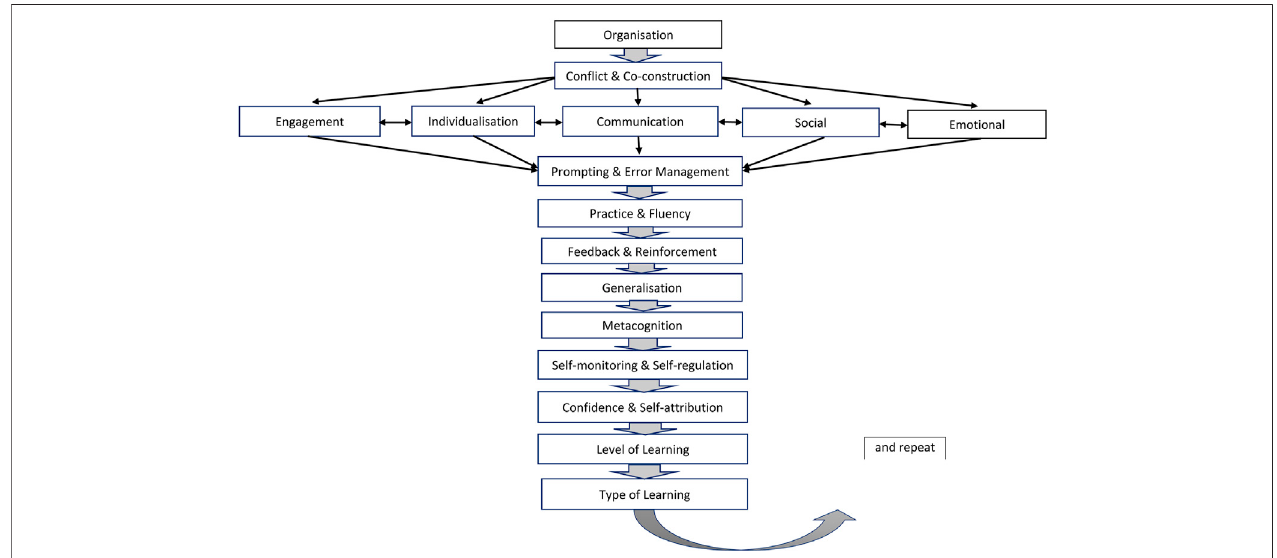
FIGURE 1 | Theoretical model of peer